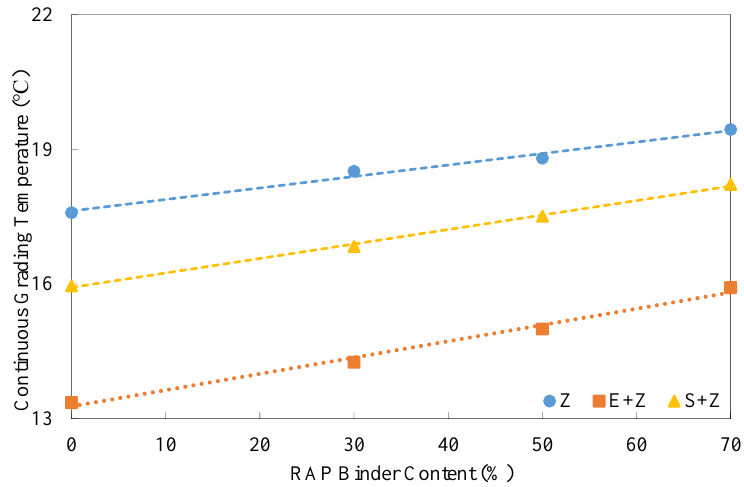
Figure 14. Intermediate-temperature continuous grading temperatures of the warm-mix recycled binders at different RAP binder contents.